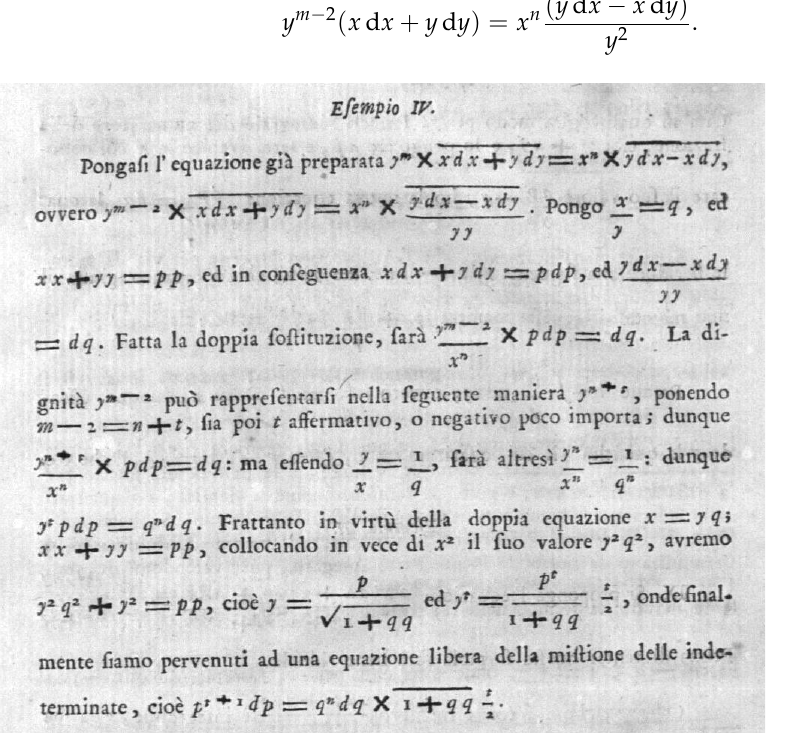
Figure 1. Riccati original treatment of